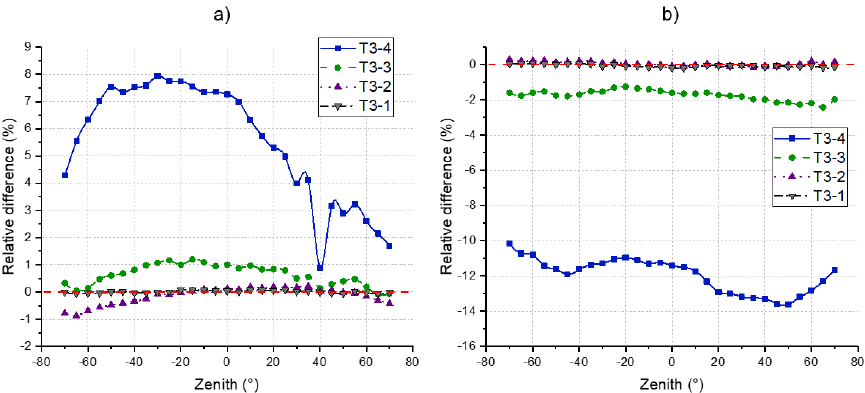
Figure 19. Contribution of single and multiple scattering to the DRF. ( a ) 670 nm, ( b ) 850 nm (third stage of growth).